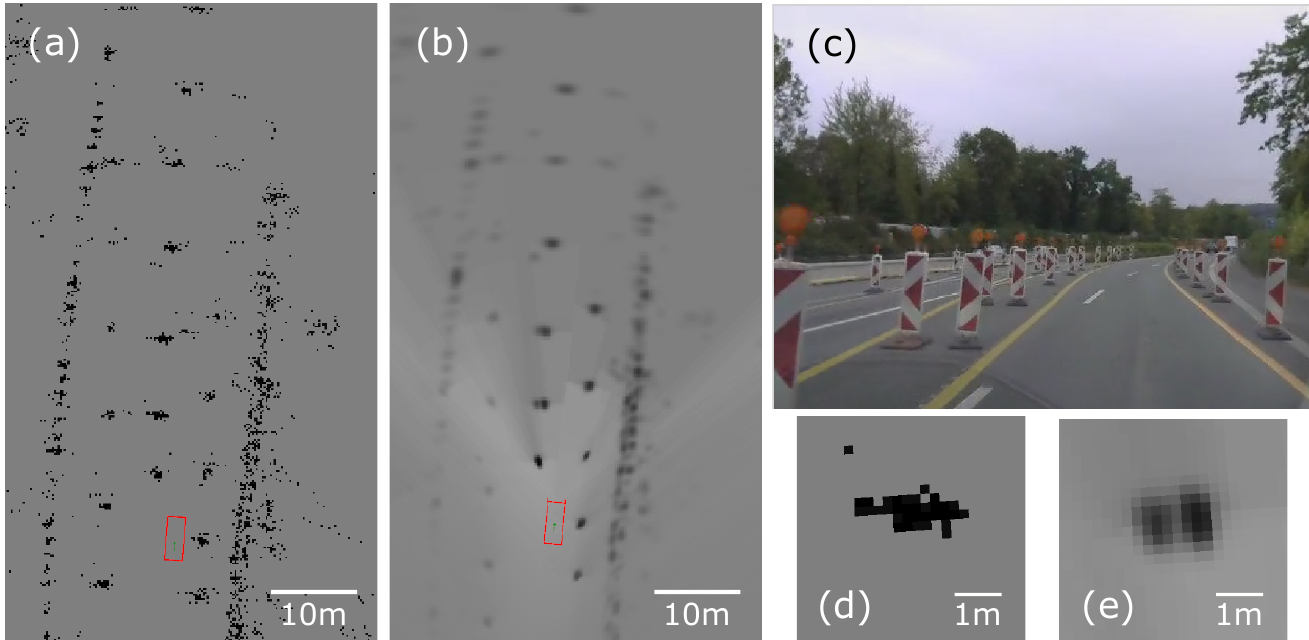
Figure 20. Experimental results for single radar occupancy grids: ( a , d ) hit point sensor model without decay and ray casting; ( b , e ) decayed and ray-cast grid with the Gaussian 2D sensor model. Image ( c ) shows the vehicle surroundings captured by the in-vehicle reference web